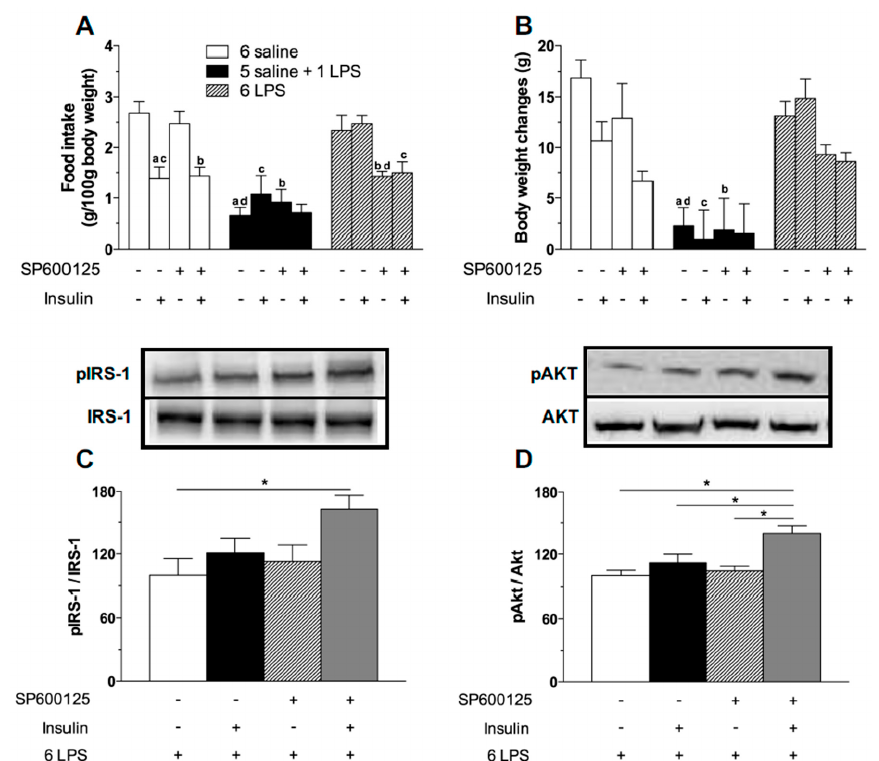
Figure 6. JNK inhibitor treatment restores the hypophagic effect of icv insulin treatment in 6 LPS- treated animals as well as restores the ability of icv insulin to phosphorylate IRS1 and AKT in 6-LPS treated rats. Effect of icv injection of vehicle (saline, 5 μ L) or insulin (12 μ M in 5 μ L) on food